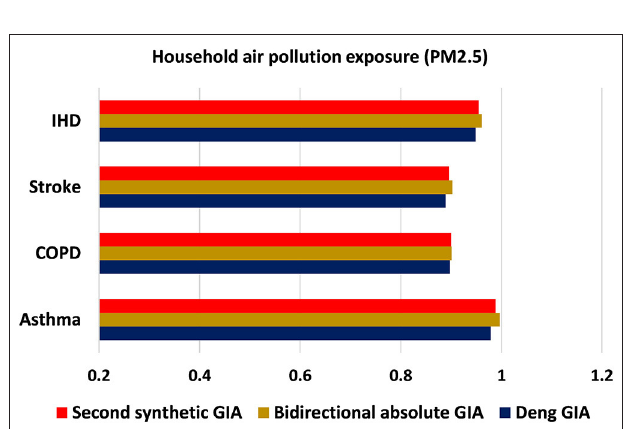
FIGURE 4 | Comparative assessment of household air pollution exposure based on